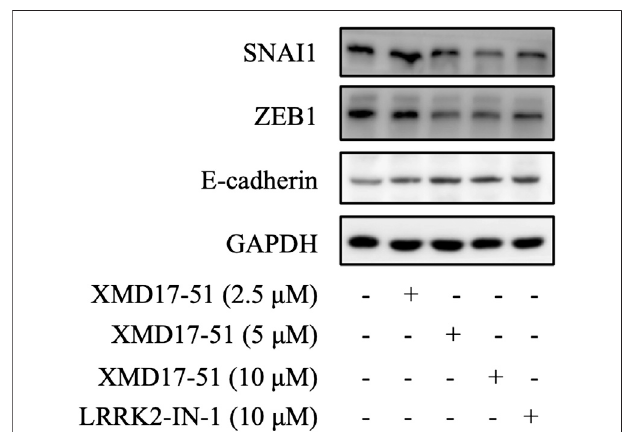
FIGURE 3 | XMD-17-51 inhibits EMT in A549 cells. Snail1, ZEB1 and E-cadherin protein levels in A549 cells were detected using western blotting following treatment with XMD-17-51. GAPDH was used as a loading control. Data shown are representative of at least three